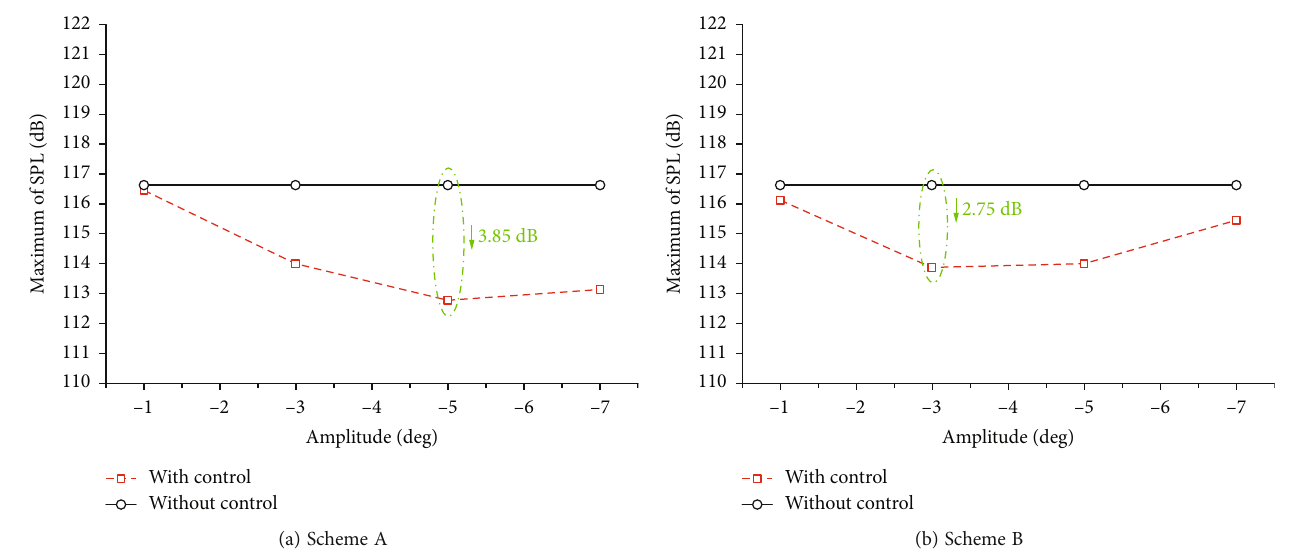
Figure 10: E ff ect of fl ap local nonharmonic inputs on maximum sound pressure level of the noise from